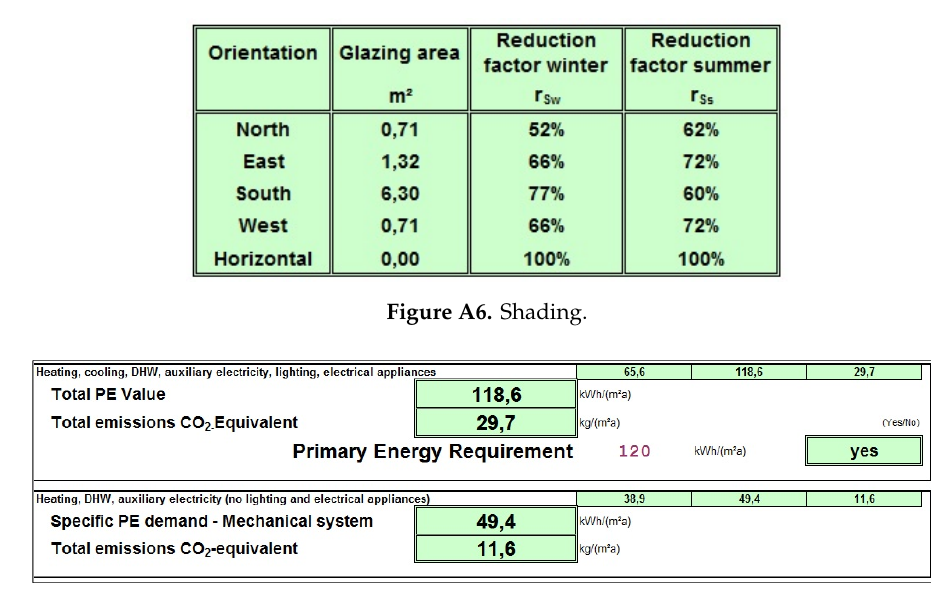
Figure A6. Shading. Figure A7. Primary Energy. Figure A7. Primary